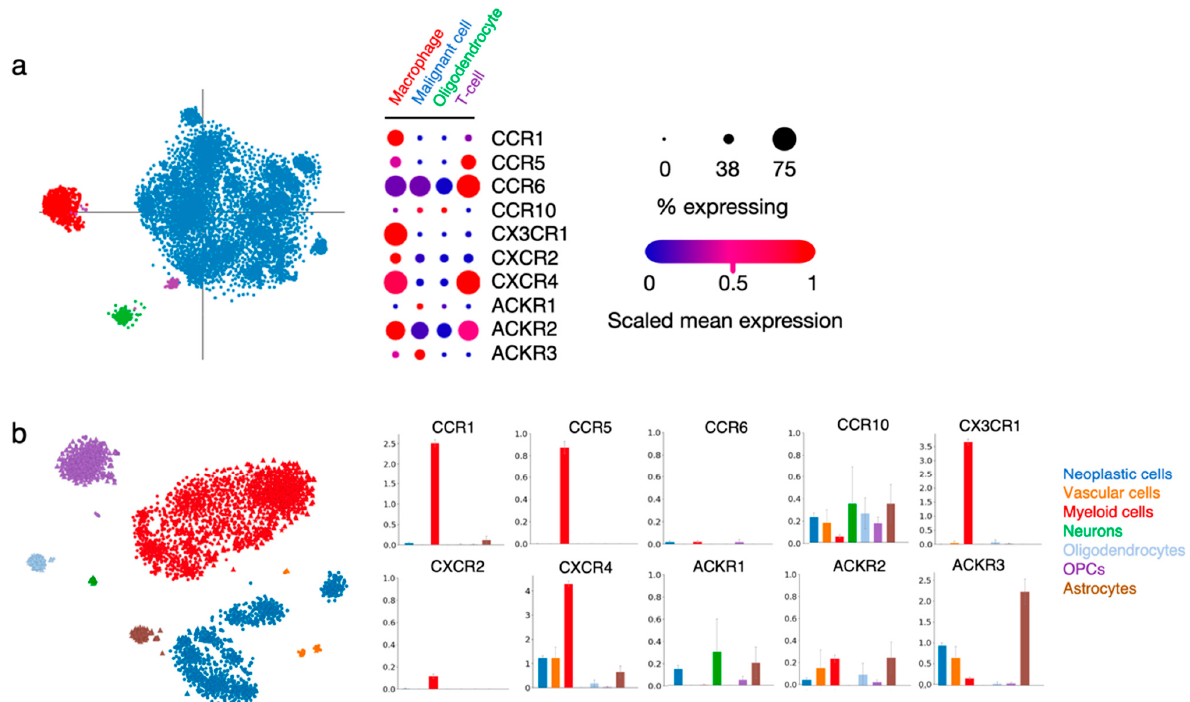
Figure 3. Chemokine receptor expression in various cell types within patient glioma samples. ( a ) Single cell RNAseq data from Neftel et al. (2019, Cell) [7] show the expression of the ten selected receptors in cells regrouped in four specific annotations (macrophage, malignant cell, oligodendro- cyte and T-cell). The “% expressing” value indicates the proportion of cells in the signature that are positive for a given transcript, and the “scaled mean expression” is relative to each gene’s expression level (logTPM) across all cells within the signature (https://singlecell.broadinstitute.org/sin-